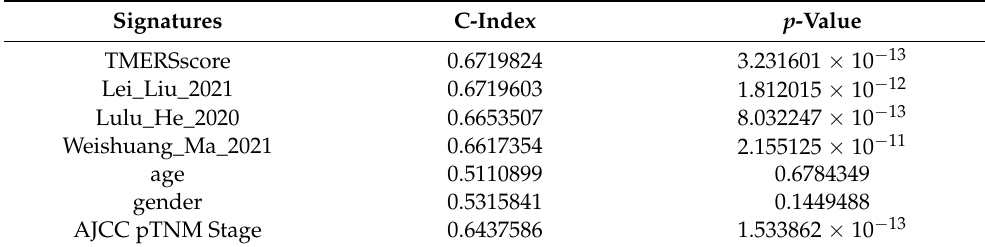
Table 2. Comparison of C-index and p -value of different models in TCGA-LUAD